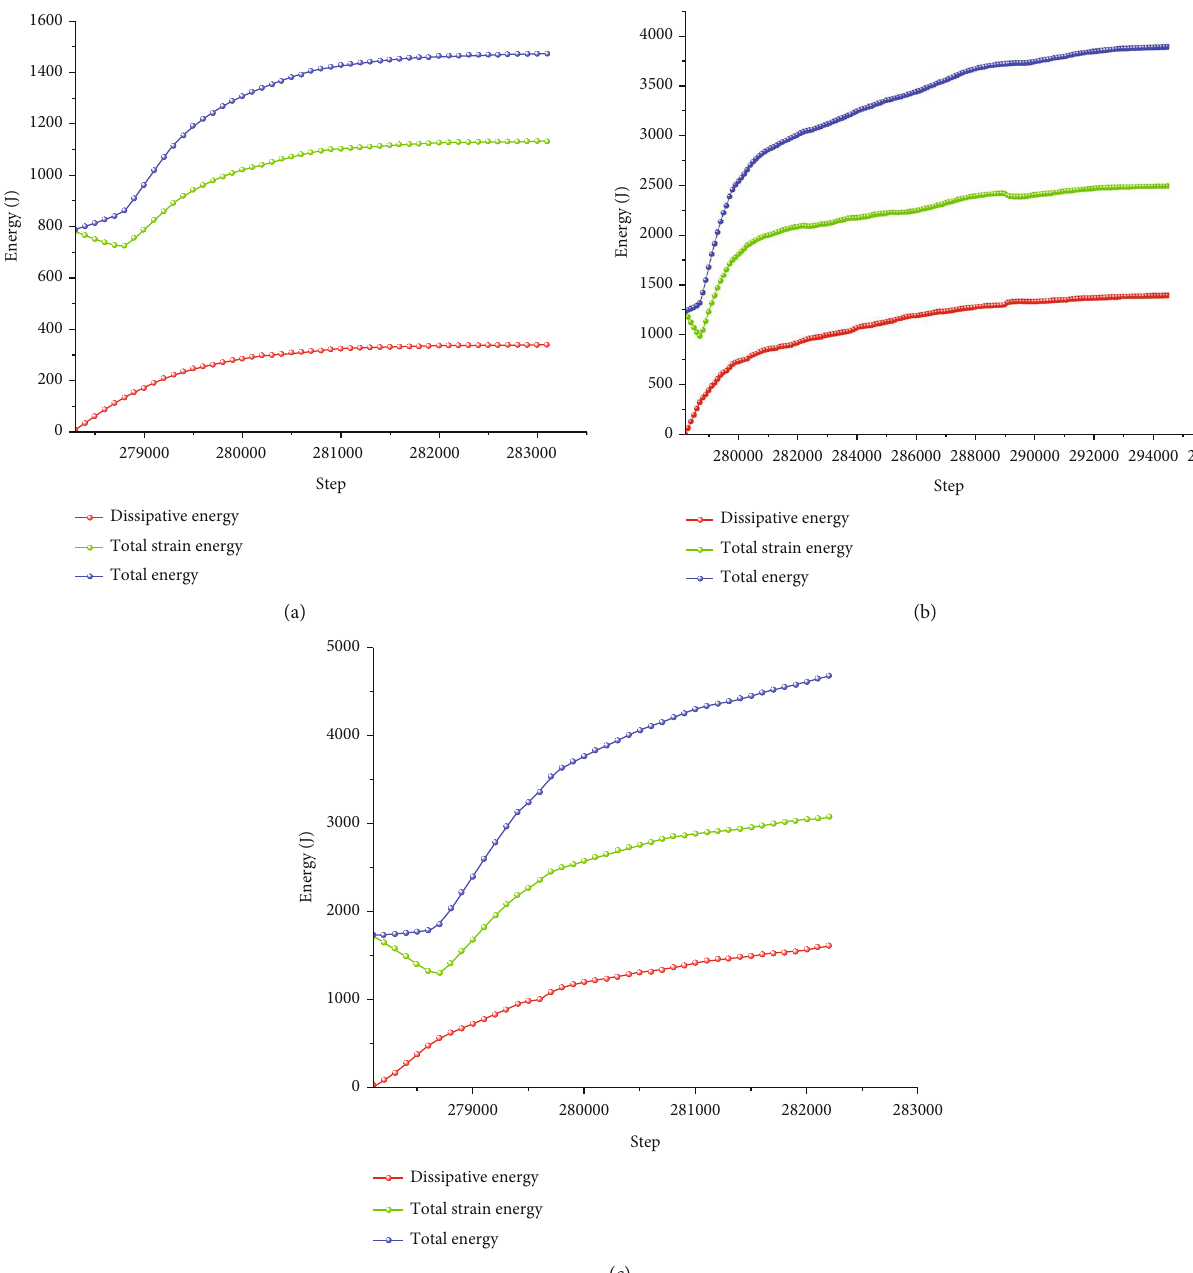
σ σ V = 60MPa, H = 50MPa . (b) V = 60